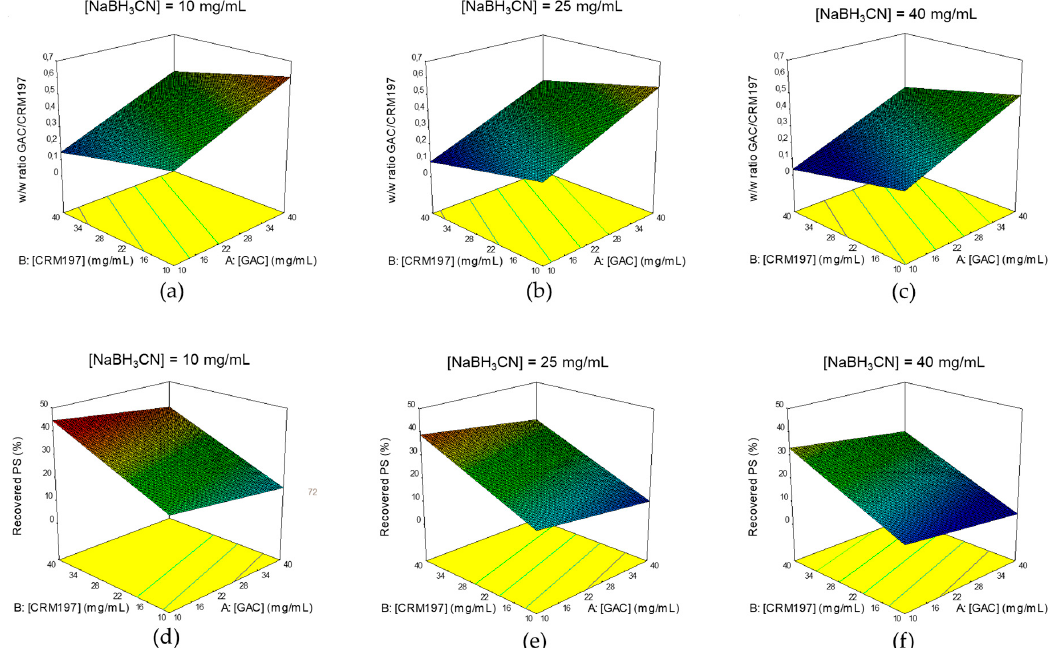
Figure 8. Identification of optimal conditions for GACox conjugation to CRM 197 : 3D Surface Model Graphs for GAC/CRM 197 w/w ratio ( a – c ) and GAC yield ( d – f ) responses. Correlation between CRM 197 and GAC concentrations at NaBH 3 CN concentrations of 10 ( a , d ), 25 ( b , e ) and 40 ( c , f ).